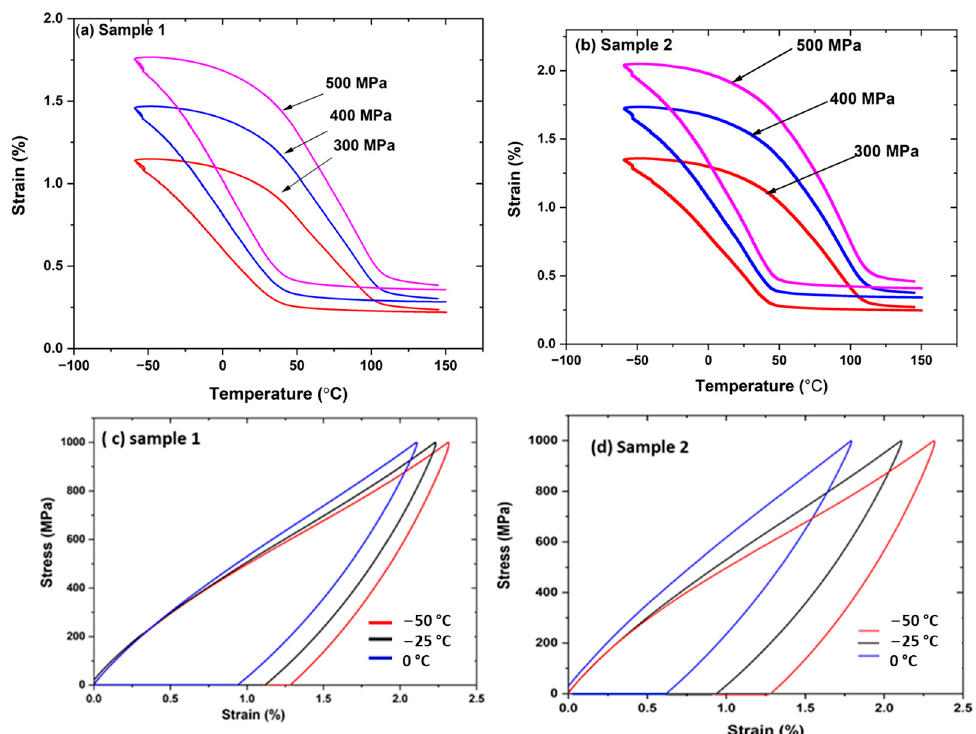
Figure 4. ( a – d ). Bending test records for plasma sprayed samples 1 and 2. ( a , b ) Strain versus temperature at various loads. ( a,b ) strain-temperature hysteresis curves at various loads shows hysteresis effect ( c,d ) Stress-strain behaviour at various temperatures shows non-elastic (hysteresis) behaviour at low temperature. (Part of the figure belongs to reference [33]).